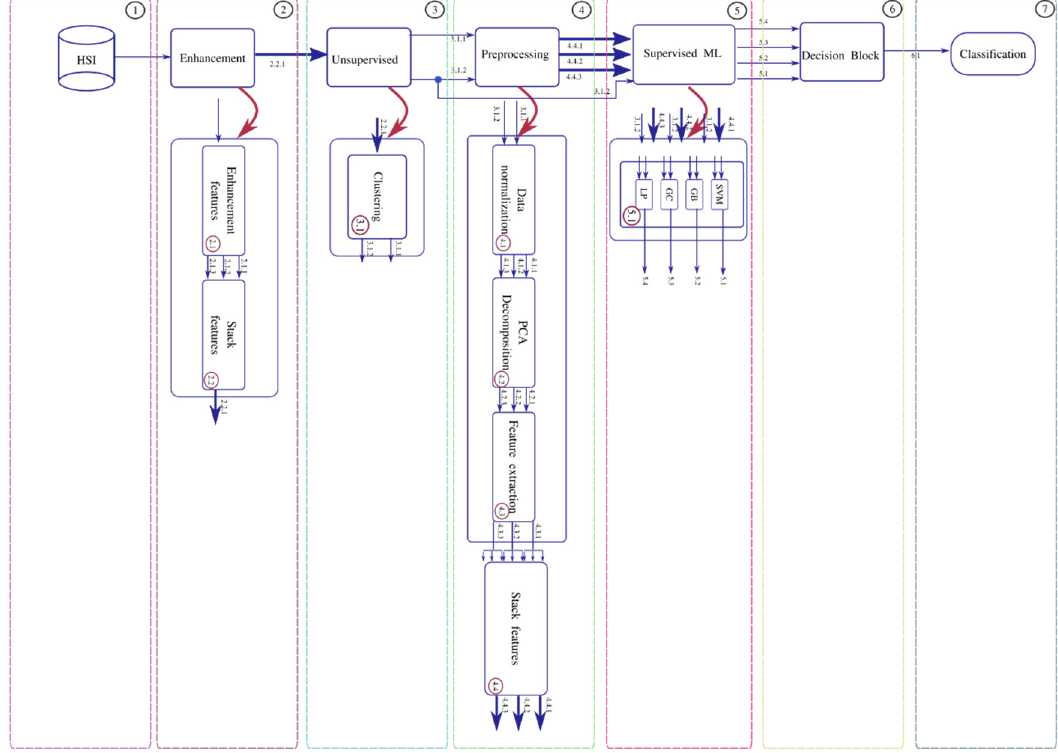
Figure 2. Block diagram for the semi-supervised hyperspectral image classification framework. The numbers on the arrows from top to bottom indicate the 3 types of scaling. The blue arrows represent the input and output for each stage, and the stages are represented by the blocks. The red arrow is a zoom into the corresponding stage showing what happens in that stage in detail.